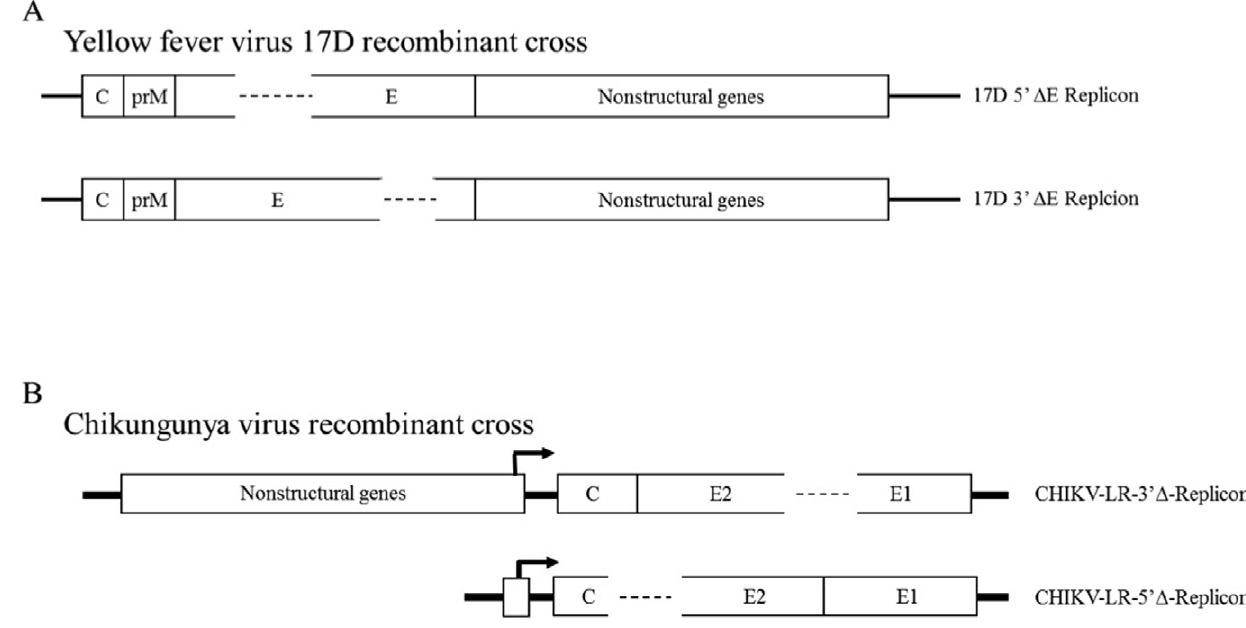
Figure 1. Schematic representation of flavivirus and alphavirus recombinant crosses. A) Yellow fever virus 17D deletion mutant replicon recombinant cross, B) chikungunya virus deletion mutant replicon/defective helper recombinant cross.